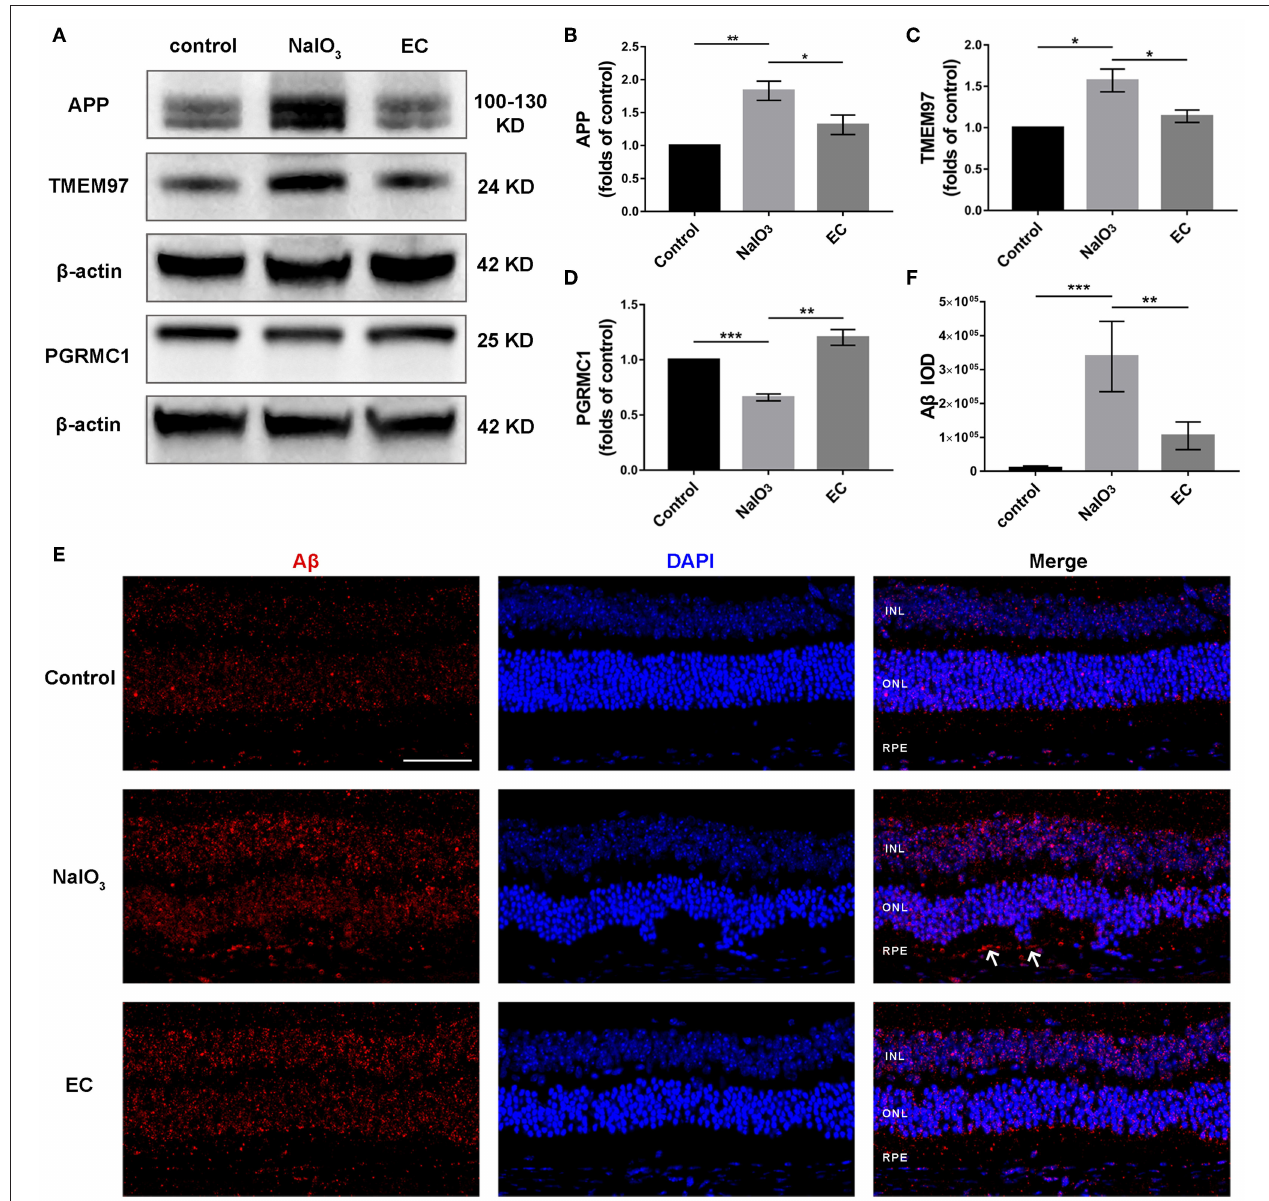
FIGURE 9 | Role of EC on the expression of APP, TMEM97, PGRMC1, and A β in retina treated with NaIO 3 . (A–D) Representative Western blot images and quantitative analysis of APP, TMEM97, and PGRMC1 levels. (E) Representative immunofluorescence images show sub-RPE A β accumulation in the three groups. (F) Quantification of A β fluorescence intensity in the RPE and sub-RPE layer. A β (red), DAPI (blue). White arrows indicate sub-RPE A β deposits. INL, inner nuclear layer; ONL, outer nuclear layer; RPE, retinal pigment epithelium. Values are presented as mean with SEM; n = 3 or 4. * p < 0.05, ** p < 0.01, *** p < 0.001.